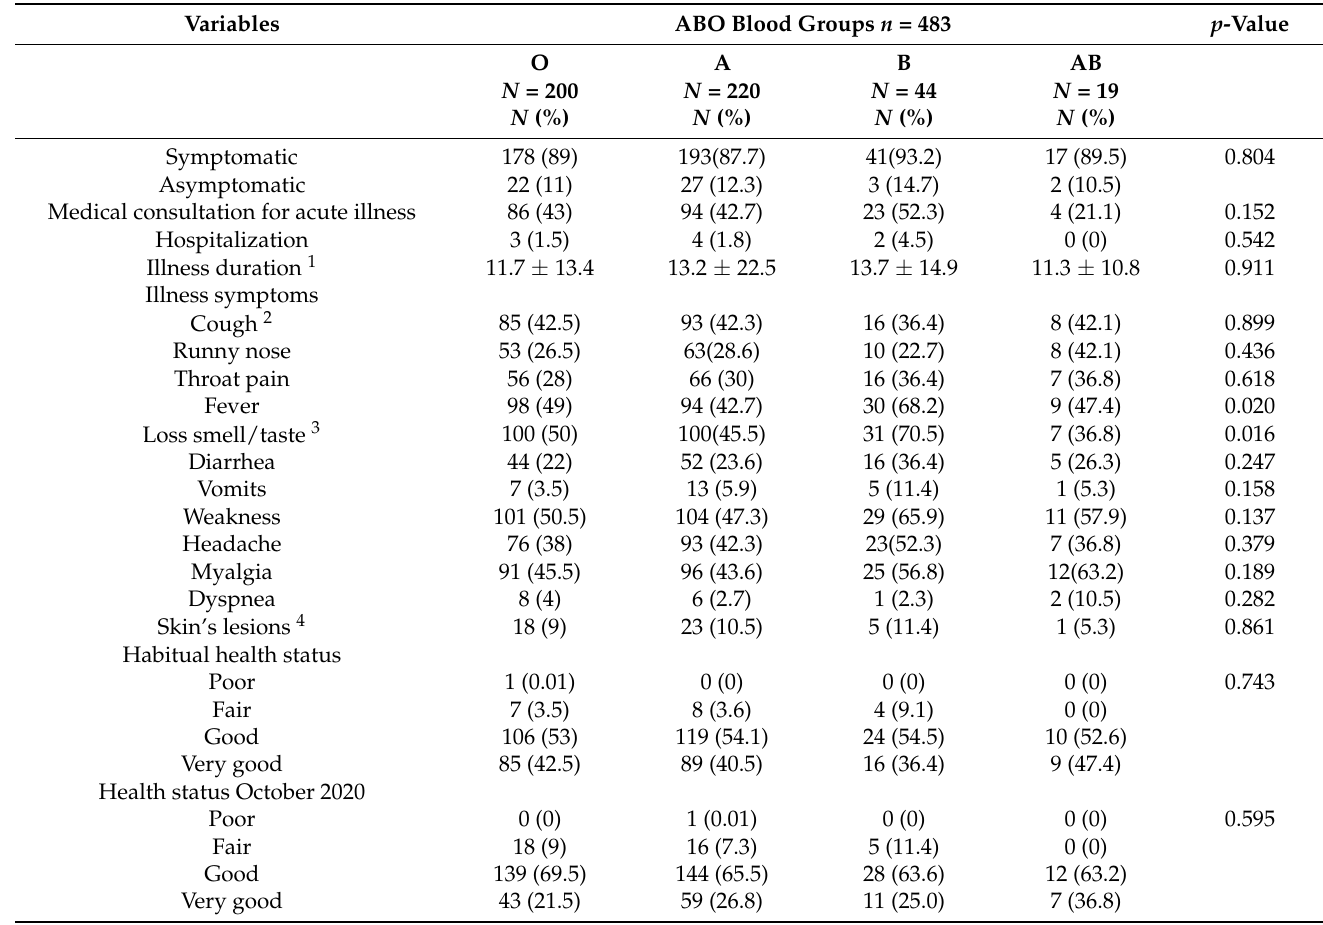
Table 3. Symptoms in the acute COVID-19 illness in March 2020 and previous health status and health status in October 2020 by ABO blood groups. Borriana COVID-19 cohort